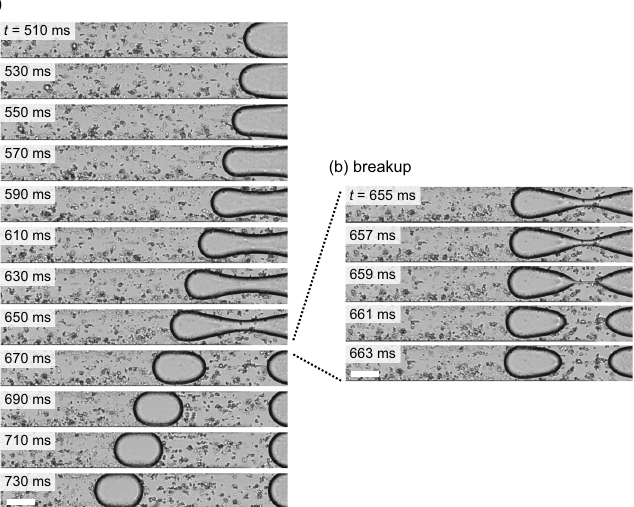
Figure 2. ( a ) Snapshots of the generation of a droplet with symmetric shape. t = 0ms was set at a timing when the NaAlg aqueous solution retreated the most during periodic dripping. ( b ) Detailed view of the split of the droplet from the NaAlg aqueous phase. All scale bars, 50 µ m. The video is available in Supplementary Materials (Video